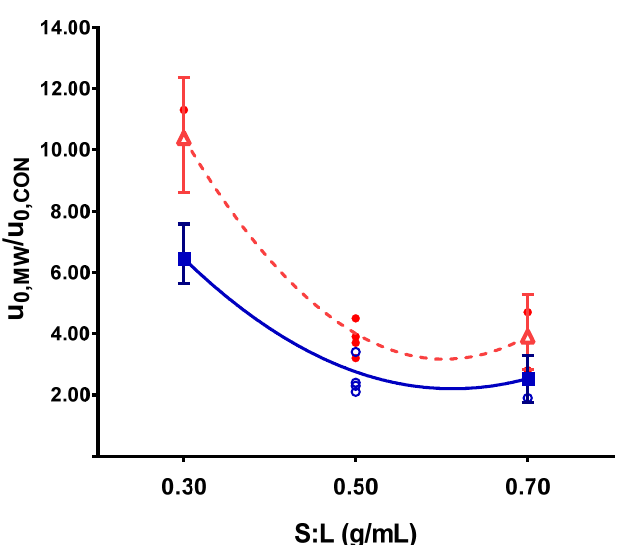
Figure 3. Solid–liquid ratio influence on initial extraction rate respect to the control for a pretreatment temperature of 80 °C ( ■ polyphenol extraction, Δ anthocyanin extraction, ○ and ● experimental points for polyphenols and anthocyanins, respectively).